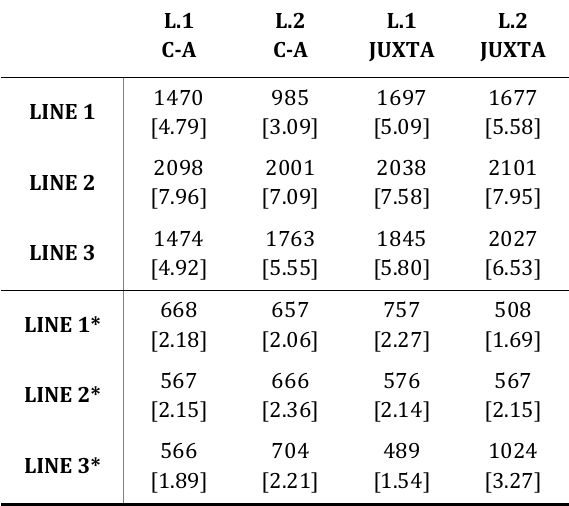
Table 1. Dwell times in ms [number of fixations in